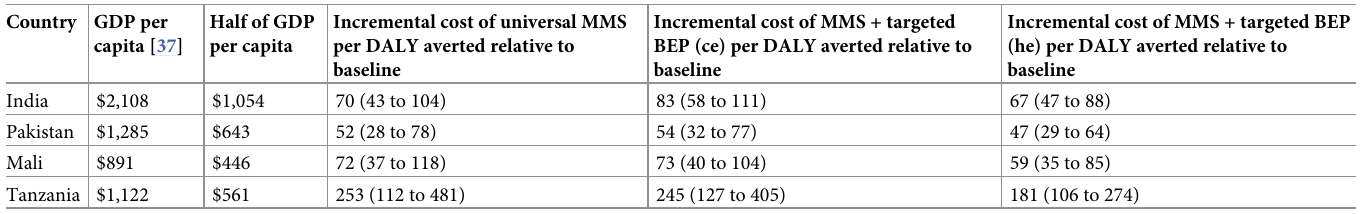
BEP, balanced energy protein; ce, current evidence effects for BEP; DALY, disability-adjusted life year; GDP, gross domestic product; he, hypothesized effects for BEP; UI, uncertainty